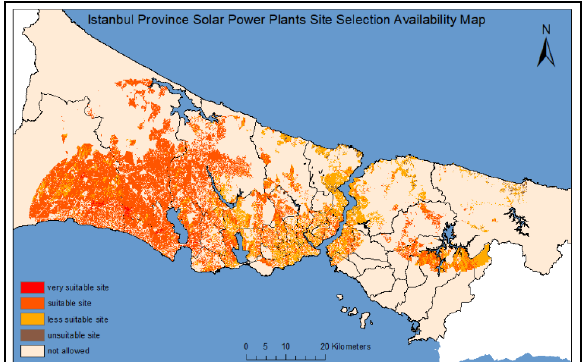
Figure 10. Istanbul Province Solar Power Plants Site Selection Availability Map